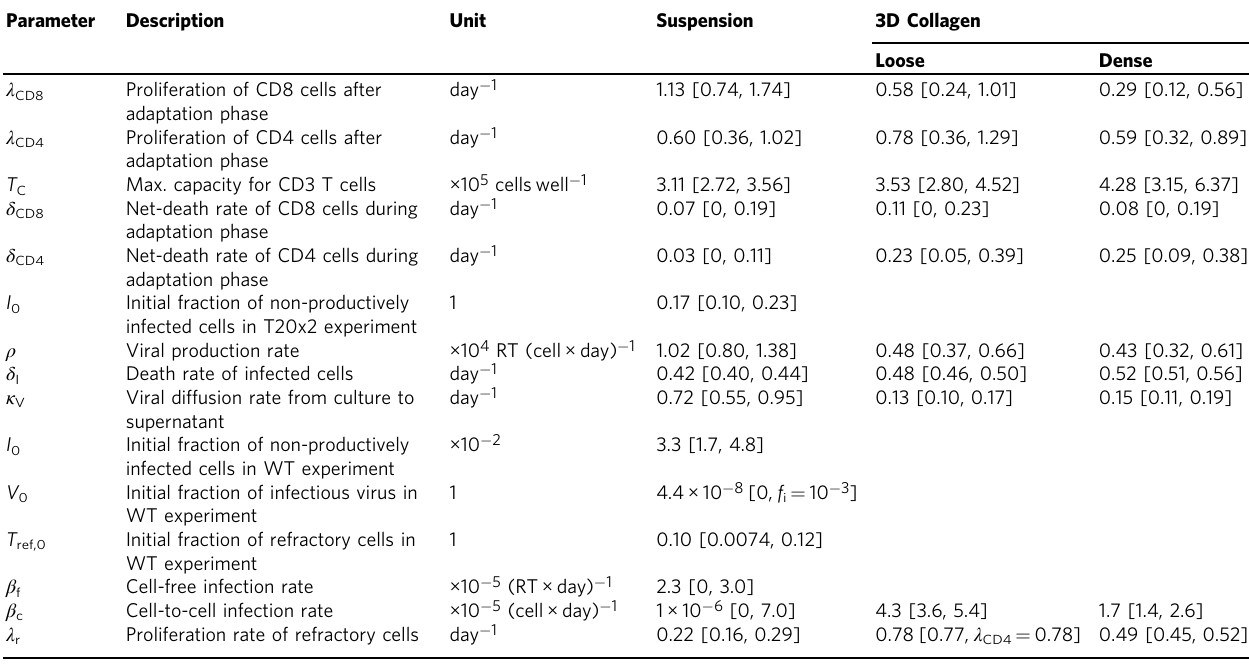
The schematic of the model is depicted in Fig. 3d, and the model and fi tting procedure is explained in detail in Methods. Numbers in brackets represent 95%-con fi dence intervals for parameter estimates obtained by pro fi le likelihood